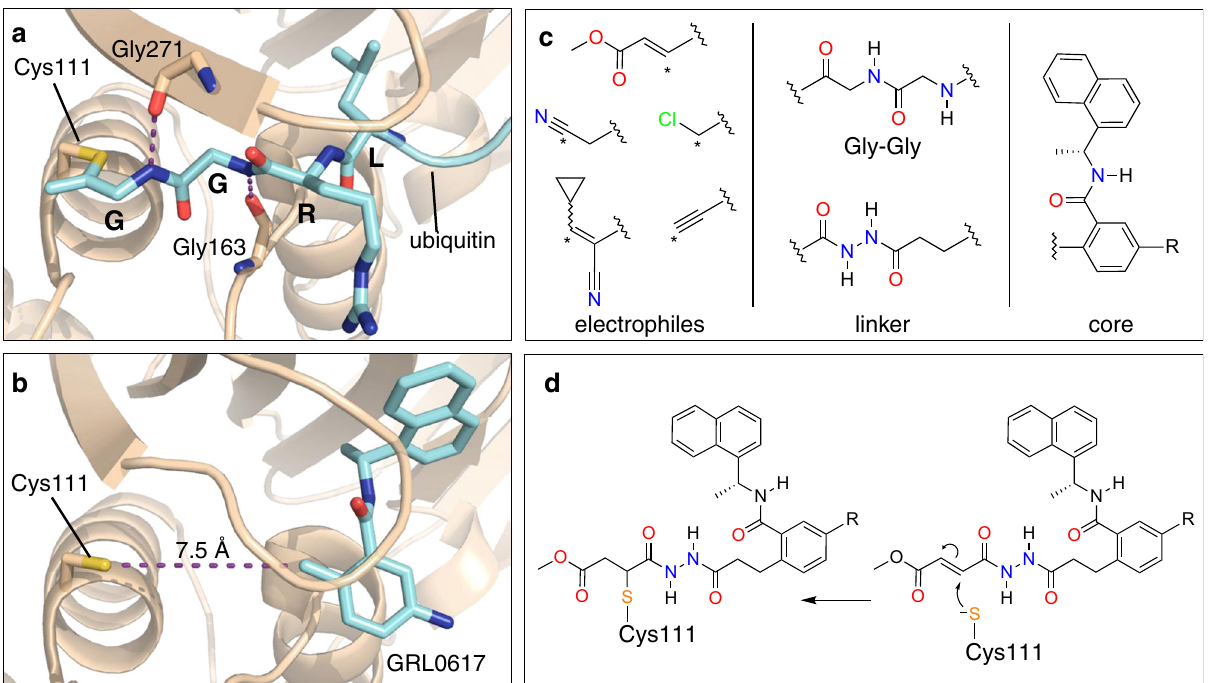
Fig.2|DesignstrategyforcovalentPLproinhibition.a X-rayco-crystalstructure of ubiquitin-propargylamine(cyan) covalentlybound to Cys111 inPLpro(tan) from PDB entry 6XAA 12 . Selected residues from PLpro and the LRGG motif of ubiquitin (cyan) are labeled and shown in stick representation. b Crystal structure of GRL0617 (cyan) bound to PLpro (PDB entry 7CMD) 18 . The distance between S γ of